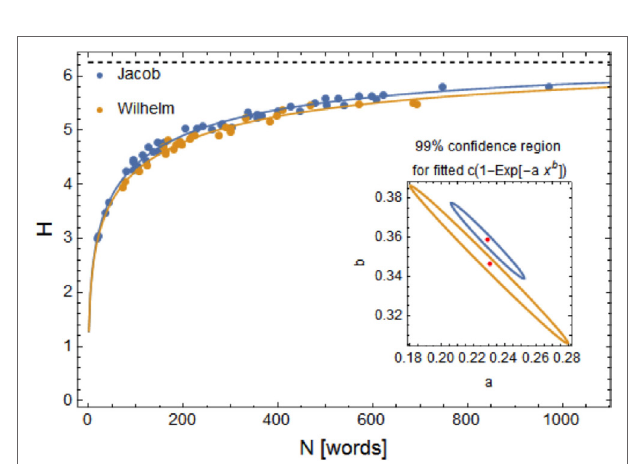
FigUre 6 | Entropy of Jacob’s and Wilhelm’s manually transcribed letters (points) shows that Jacob has a greater lexical diversity. The result is statistically significant at a 0.99 confidence level (see inset). The black dashed line represents the fitted asymptote c common to both curves.